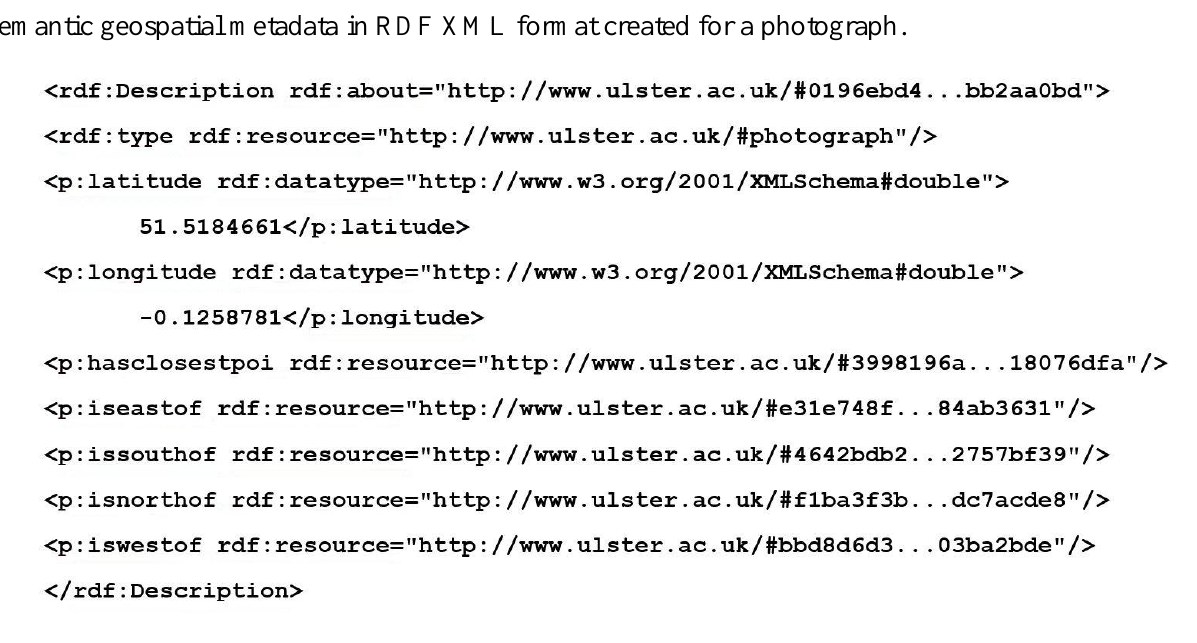
Figure 2. Snippet of RDF XML created for a photograph by MediaPlace. The 256 bit SHA hash has been abbreviated for improved presentation